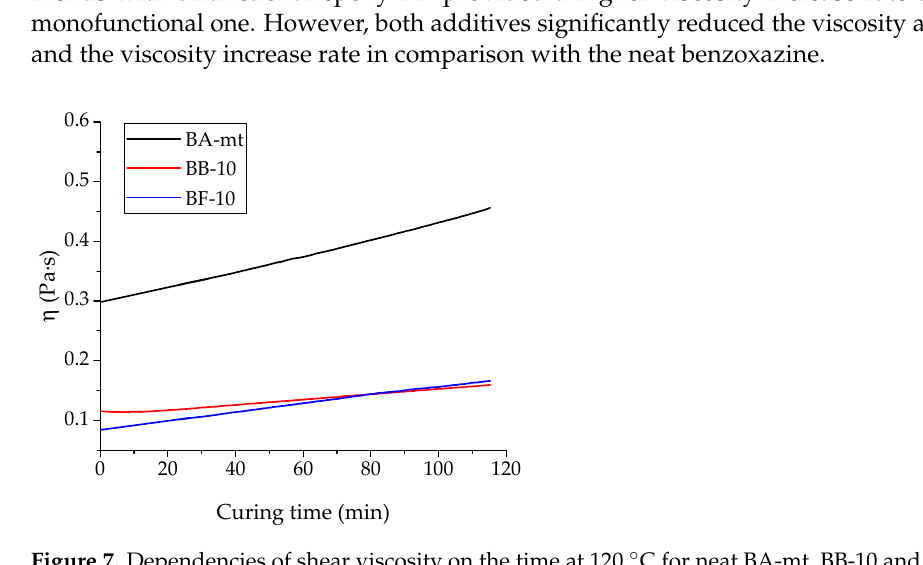
Figure 7. Dependencies of shear viscosity on the time at 120 ° C for neat BA-mt, BB-10 and BF-10. As mentioned in Section 3.2, blends with epoxies were not in a glassy state at 25 ◦ C instead of neat BA-mt. Values of viscosity measured at 40 ◦ C are listed in Table 3. FUR turned out to be 30%–40% more efficient in the reduction of viscosity compared to BD. Thus, values of viscosity for compositions with 10 phr of BD and FUR were 850 Pa · s and 503 Pa · s respectively and the viscosity of neat BA-mt was 59,000 Pa ·